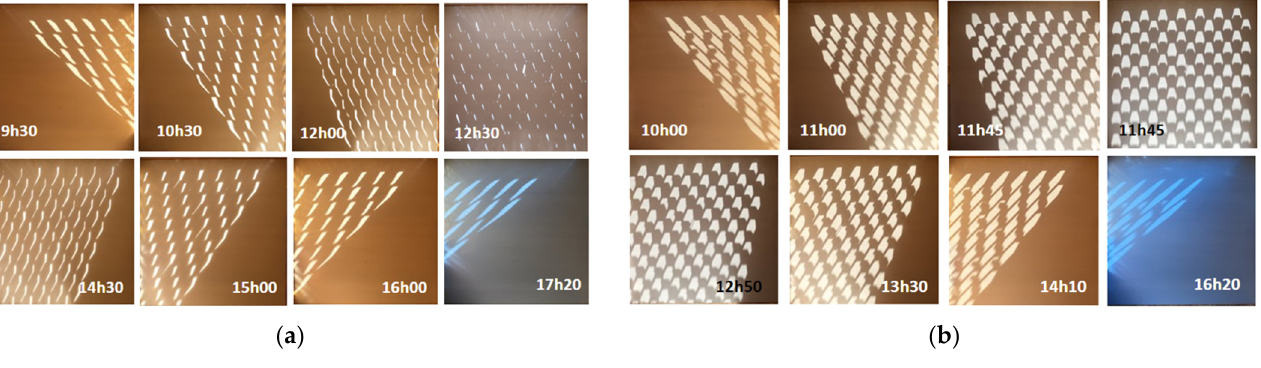
Figure 12. Light and shadow projection on the floor of the test box at different hours of the day for two opening angles of flaps: ( a ) angle at 45° on November 12, and ( b ) angle at 90° on November 16. Blue light at the end of the day is due to more diffuse illumination than the rest of the day.